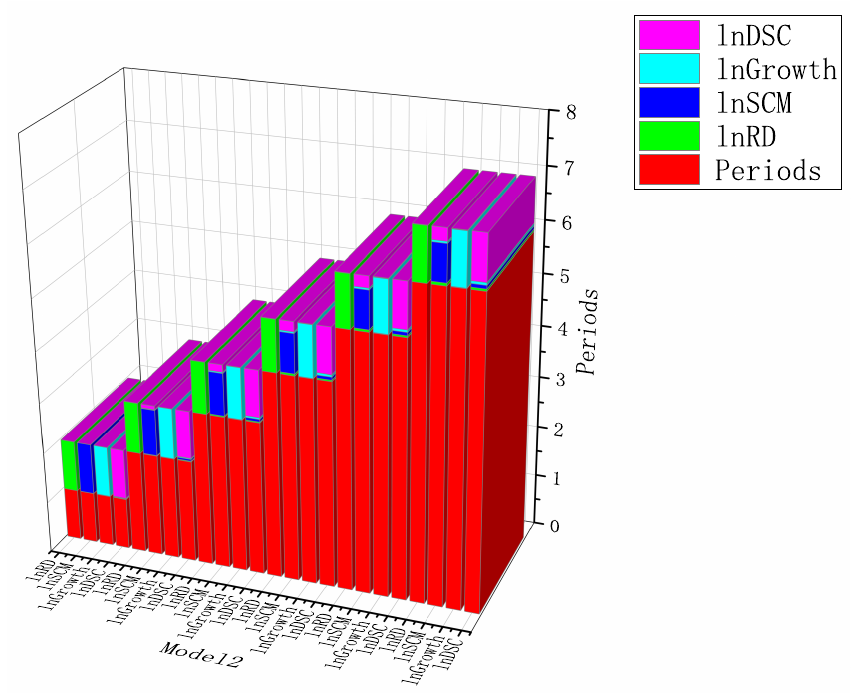
Figure 13. The graph shows the results of the variance decomposition of Model 2. The horizontal axis indicates the different variables including debt servicing capacity (lnDSC) (in Magenta), growth capacity (lnGrowth) (in light blue), supply chain management (lnSCM) (in blue), and R&D innovation (lnR&D) (in green), the vertical axis indicates the contribution of each variable at different lags (see Appendix A for specific figures), and the red area indicates the number of periods